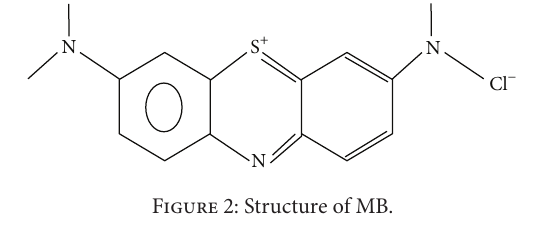
Figure 2: Structure of MB.